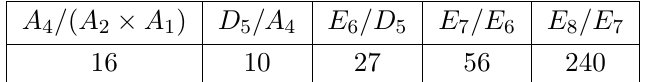
(cid:0) (cid:1) W ( E n ) =W ( E n (cid:0) 1 )